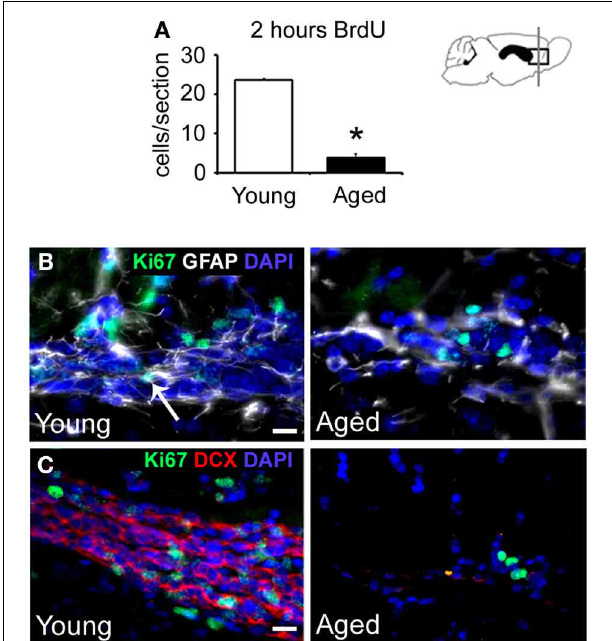
FIGURE 3 | Aging decreases the population of proliferating cells in the RMS. (A) Bar graph depicting the number of BrdU + cells in coronal sections of the RMS, 2h after BrdU administration. Note the significant decrease of proliferative cells in the aged RMS. (B) Immunoassay against Ki67 (green) and GFAP (white) in sagittal sections of the RMS. The number of Ki67 + was drastically reduced in aged mice, while GFAP + cells were maintained during aging. Note the presence of double Ki67/GFAP + cells (arrow) in the young RMS. (C) Immunoassay against Ki67 (green) and DCX (red) in sagittal sections of the RMS. The number of both Ki67 + and DCX + cells was drastically reduced in aged mice. Scale bar: B,C = 10 µ m. ∗ p < 0 .